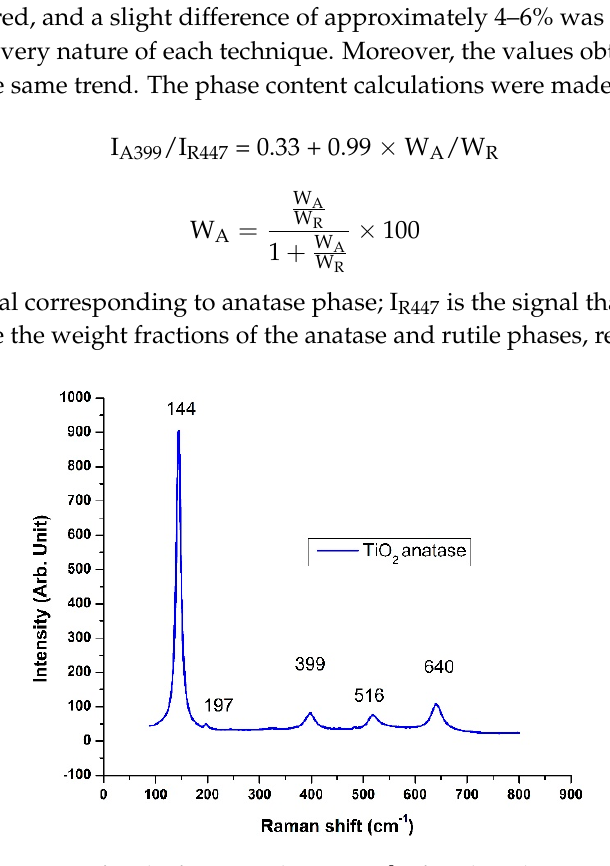
Figure 2. Raman spectrum after the first annealing at 250 °C for 2 h under an ambient atmosphere.